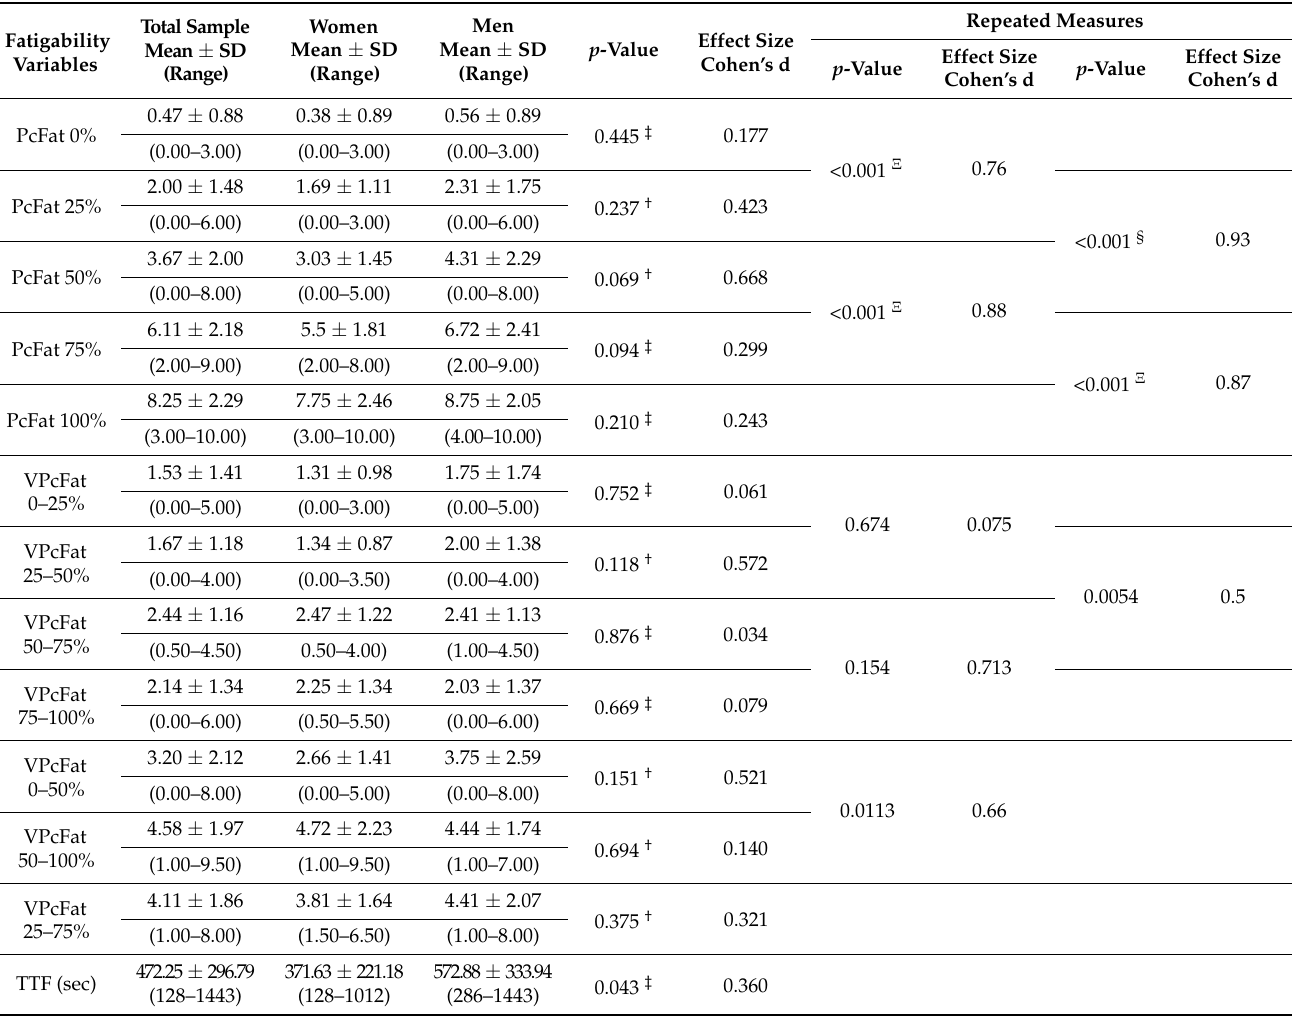
Table 4. Perceived and performance fatigability